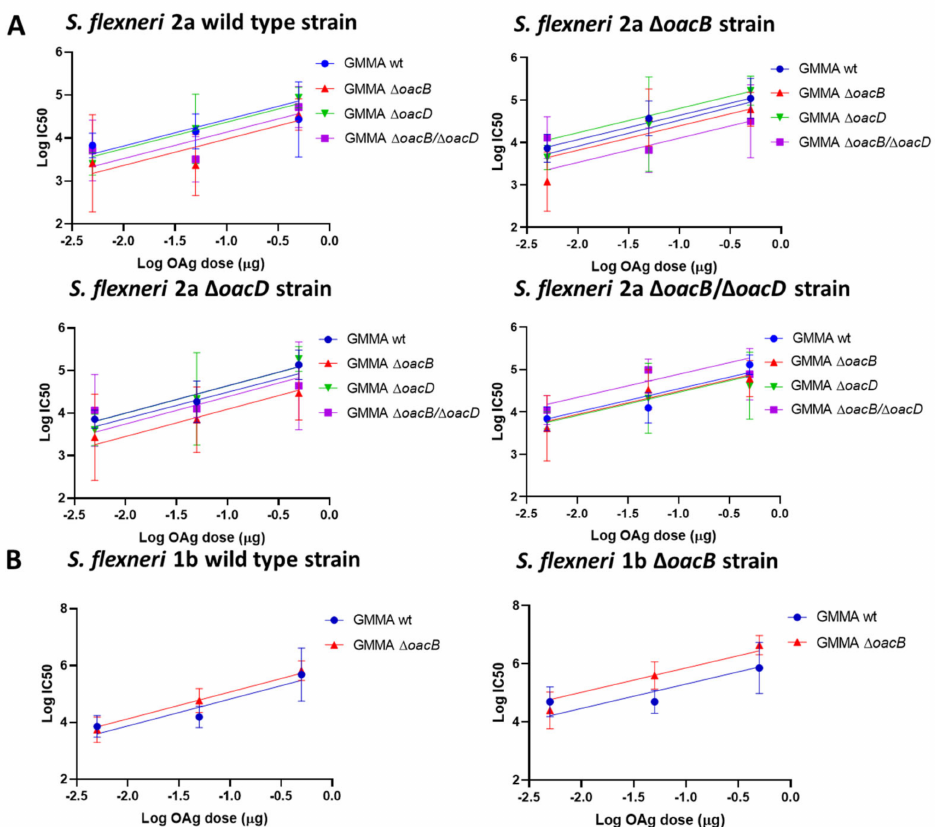
Figure 3. L-SBA results against homologous strains differing for O-acetylation pattern (indicated as titles of each graph). Parallel line analysis showed that slopes and Y-intercepts of the dose- response curves of the different formulations (reporting log transformed IC50 titers in Y axis and log transformed OAg doses in X axis) were not statistically significantly different both in the case of S. flexneri 2a ( A ) and S. flexneri 1b ( B ), being their p -values above the specified alpha of